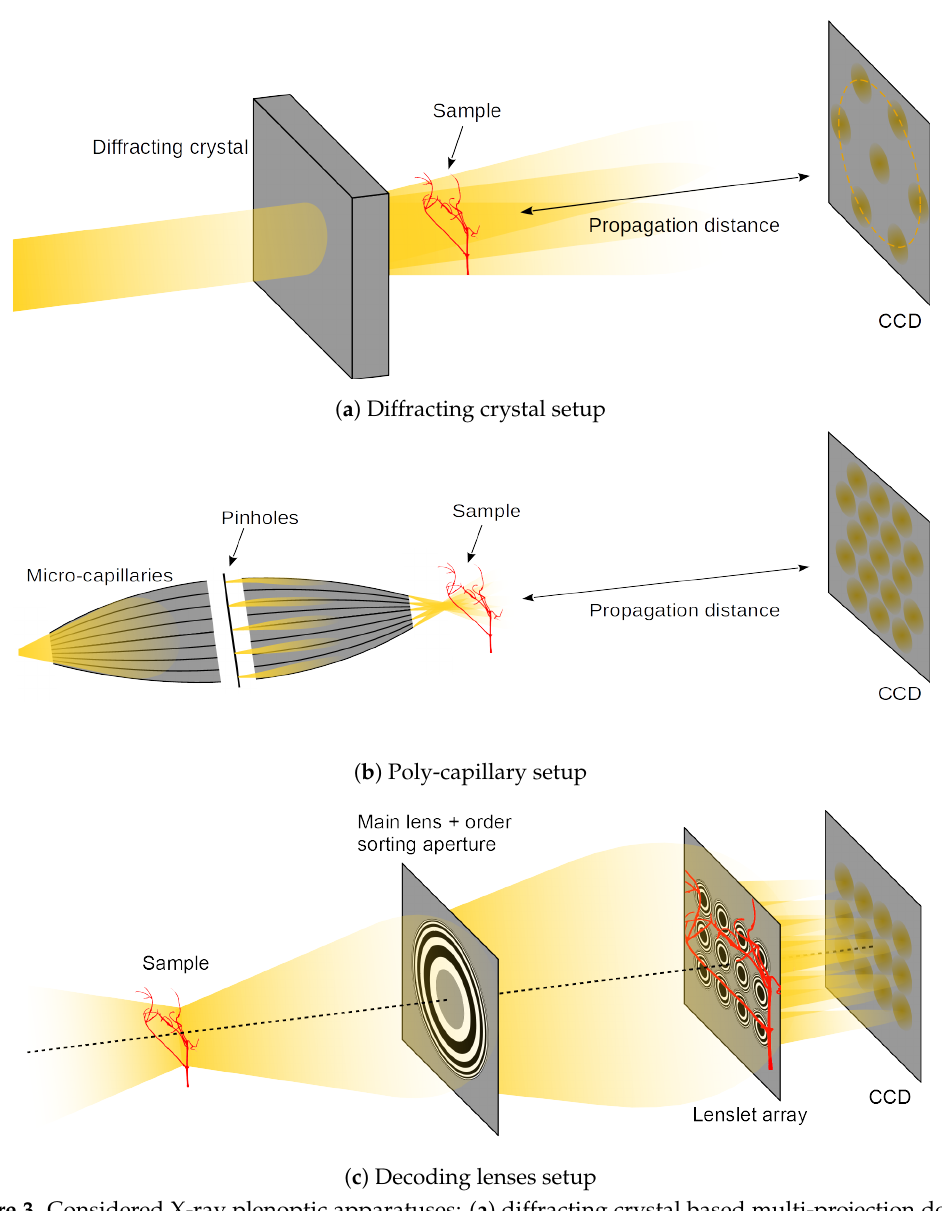
Figure 3. Considered X-ray plenoptic apparatuses: ( a ) diffracting crystal based multi-projection design; ( b ) poly-capillary based multi-projection design; and, ( c ) lenses-based X-ray plenoptic camera